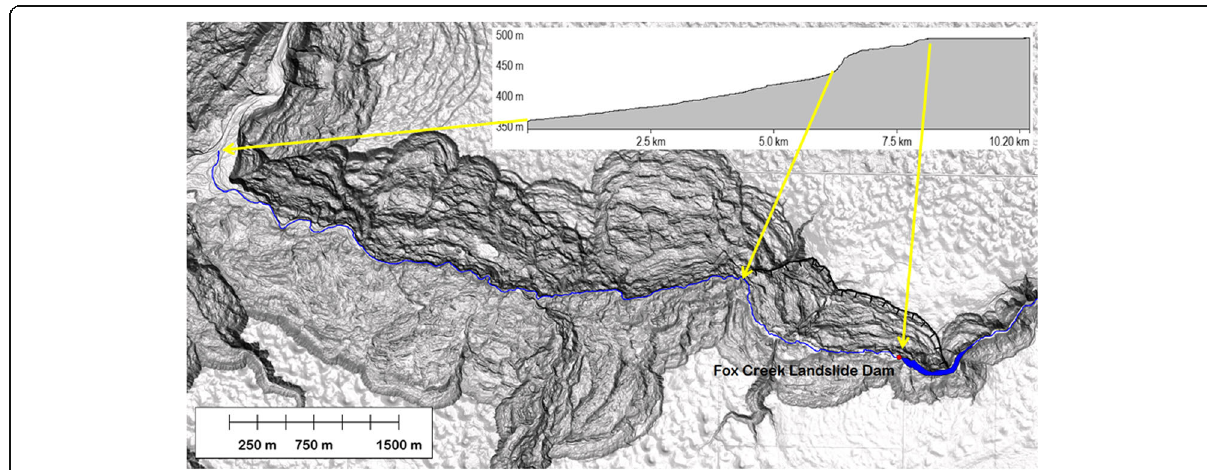
Fig. 8 Plan view and channel longitudinal profile of Fox Creek, generated from 2 m lidar (dated October, 22, 2013; source: Government of Alberta, reproduced with permission). The black hatched line traces the landslide ’ s main scarp. A continued, pronounced effect of the landslide